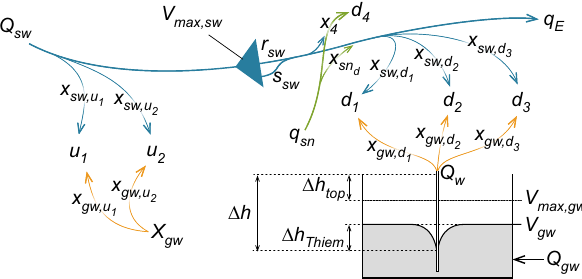
Figure 2. Conceptual sketch of the simplified water management problem. Water users are located upstream ( u ) and downstream ( d ) of a surface water reservoir. Allocation decision variables for sur- face water (blue), SNWTP water (green), and groundwater (orange) are indicated. The conceptual sketch of the downstream dynamic aquifer shows how the total lift ( (cid:49)h ) is composed of the thickness of the top layer, the regional groundwater drawdown, and the local Thiem steady-state groundwater